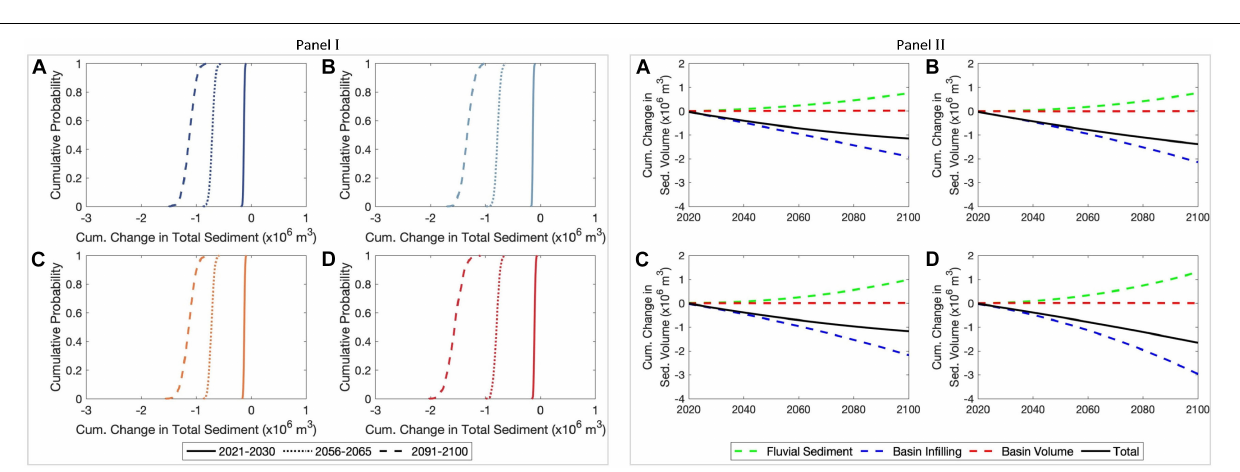
FIGURE 7 | Empirical cumulative distributions of the projected change in total sediment volume exchange ( (cid:49) V T ) between the Alsea estuary and the adjacent coast over the three decadal periods considered (Panel I) . The empirical cumulative distributions were developed by averaging the projected (cid:49) V T values over the three decadal periods considered. (Panel II) shows the computed variations of the projected 50 th percentile values of change in total sediment volume exchange ( (cid:49) V T ) and contributions from different processes to (cid:49) V T at the Alsea estuary over the 21 st century. Negative volumes indicate that the estuary traps more sediment at the expense of the open coast (i.e., sediment importing estuary). Subplots (A) , (B) , (C) , and (D) are for the RCPs 2.6, 4.5, 6.0, and 8.5,